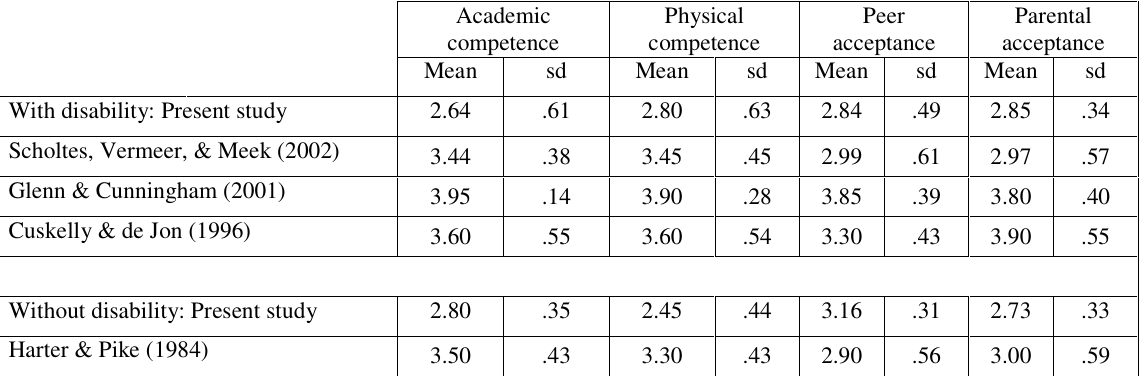
Means and standard deviation values for each self-domain from students with and without disability